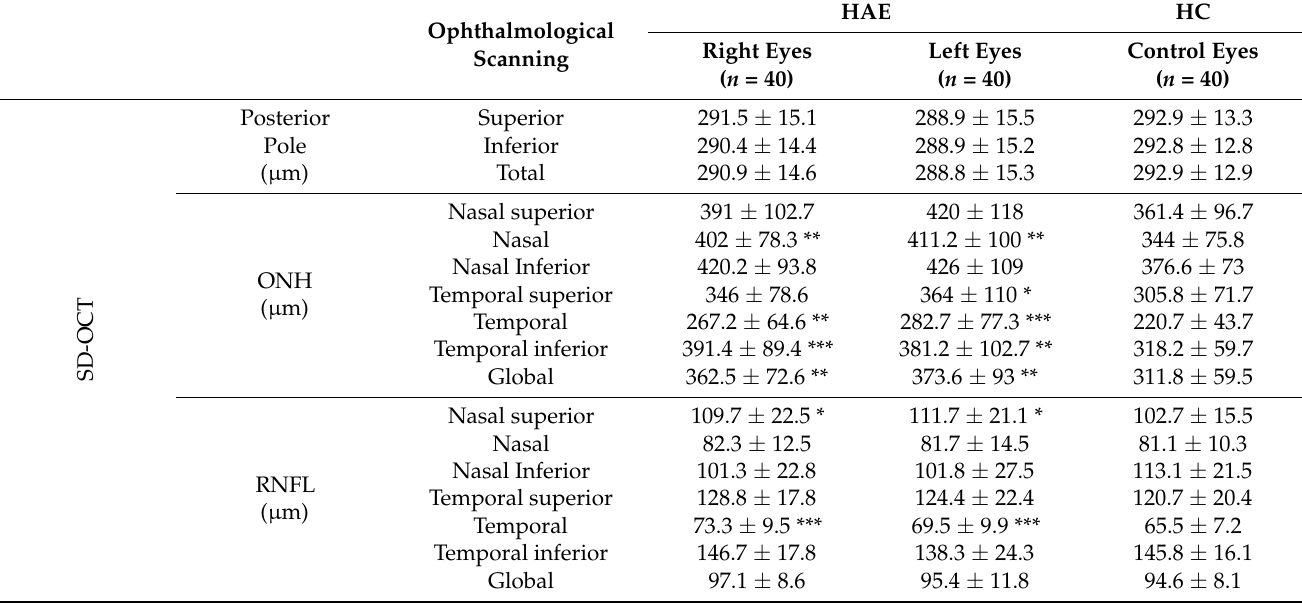
Figure 1. The total retinal thickness of the posterior pole. ( A ) patients. ( B ) controls. Table 2. SD-OCT e OCT-A findings from the study